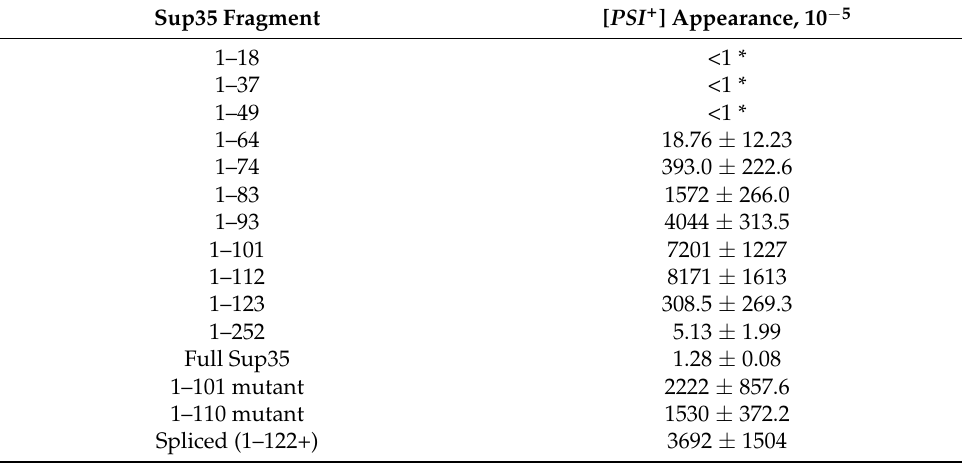
Table 1. Frequency of the [ PSI + ] de novo appearance upon production of Sup35 N -terminal frag- ments.